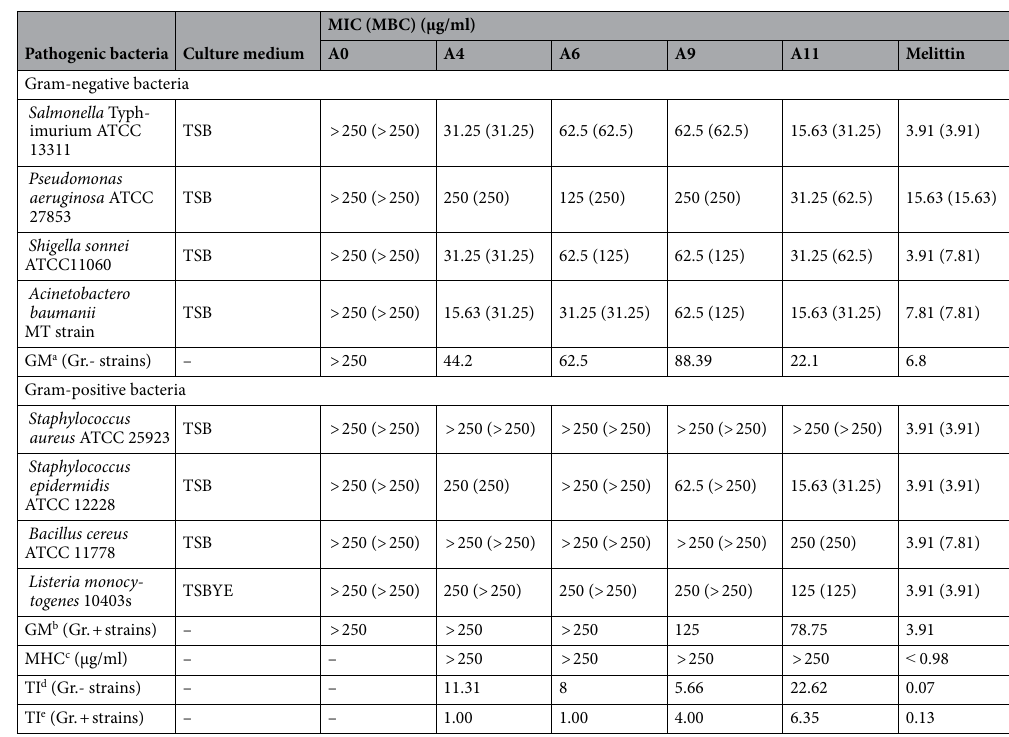
Table 1. Minimum inhibitory concentration (MIC) and minimum bactericidal concentration (MBC) of acidocin J1132β derivatives against 9 strains of pathogenic bacteria. TSB tryptic soy broth, TSBYE tryptic soy broth supplemented with 0.6% yeast extract. a GM (Gr.− strains) denotes the geometric mean of MIC values from all Gram-negative strains. b GM (Gr.+ strains) denotes the geometric mean of MIC values from all Gram-positive strains. c MHC is the minimum concentration that caused 10% hemolysis of human red blood cells (hRBC). When no 10% hemolysis, as well as > 10% hemolysis, were observed at 250 µg/ml and 0.98 µg/ ml, values of 500 µg/ml and 0.49 µg/ml were used to calculate the therapeutic index, respectively. d Therapeutic index (Gr.− strains) is the ratio of the MHC to the geometric mean of MICs from Gram-negative strains. e Therapeutic index (Gr.+ strains) is the ratio of the MHC to the geometric mean of MICs from all Gram- positive